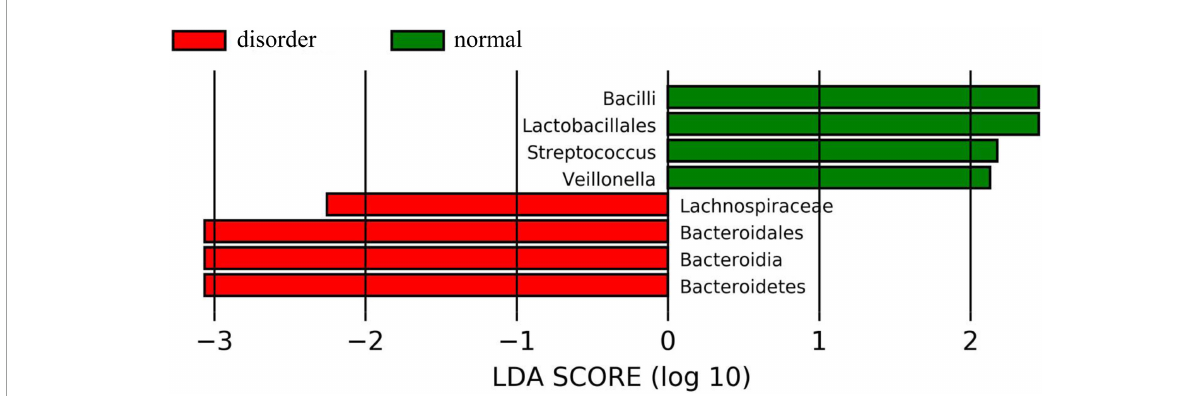
FIGURE5 The histogram of group value distribution by grouping comparison and analysis. The ordinate is the biomarker with a statistical difference, and the abscissa is the LDA score. The higher the LDA score, the more significant the difference between groups. The color of the bar chart represents the respective groups. There were significant differences in intestinal flora between the normal sleep group and the sleep disorder group after TBI. Bacilli, Lactobacillales, Streptococcus, and Veillonella were dominant in the normal sleep group, and Lachnospiraceae, Bacteroidales, Bacteroidia, and Bacteroidetes were dominant in the sleep disorder